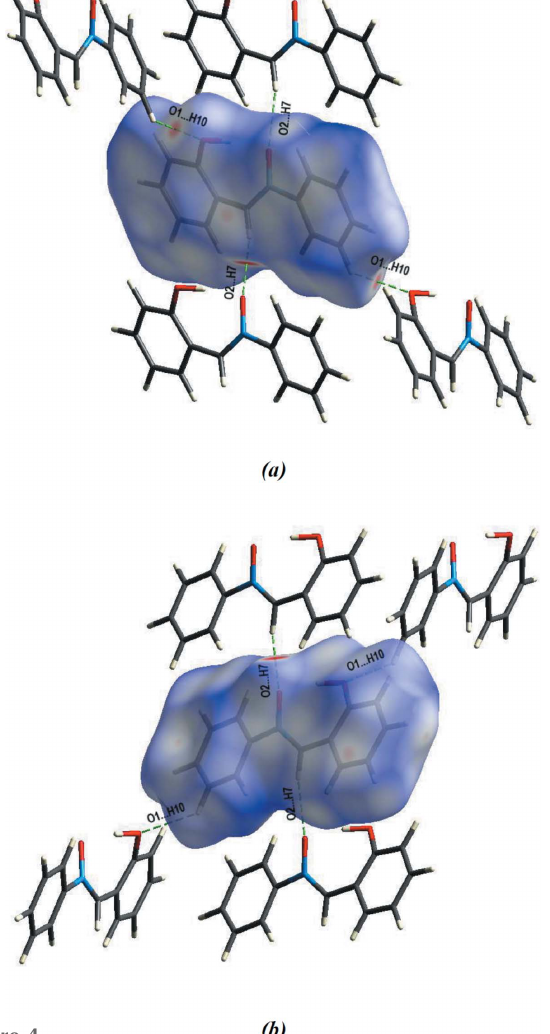
Figure 4 A view of the three-dimensional Hirshfeld surface with the C—H (cid:2)(cid:2)(cid:2) O interactions for the title compound, plotted over d norm in the range (cid:3) 0.2242 to 1.2146 a.u. ( a ) front view, ( b ) back view.